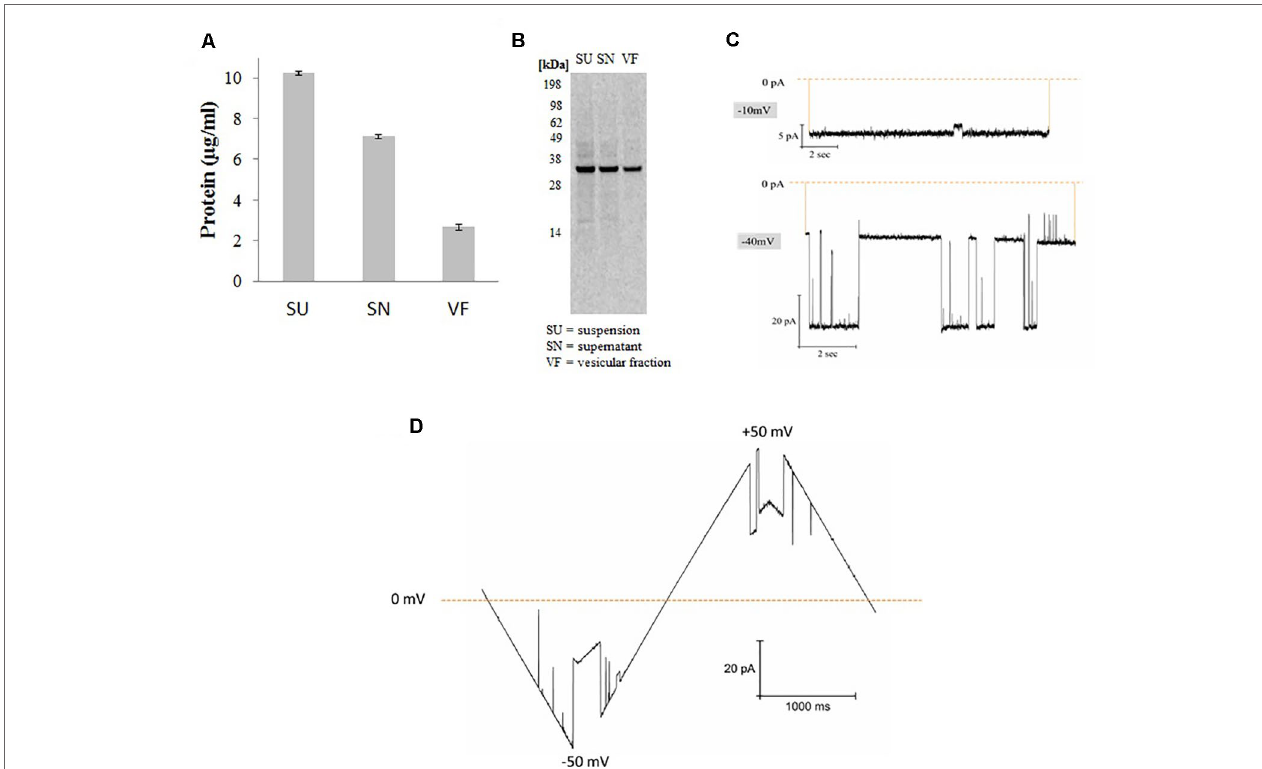
FIGURE 1 | Synthesis and functional analysis of cell-free synthesized hVDAC1. (A) Quantification was performed by hot TCA precipitation of 14C Leucine labeled protein. (B) The cell-free reaction was separated using a 10% SDS polyacrylamide gel. (C) Functional analysis of proteoliposomes derived from microsomes harboring hVDAC1 at -10 and -40 mV. (D) Current response to a voltage ramp applied to a single hVDAC1; the membrane voltage was changed linearly between −50 and +50